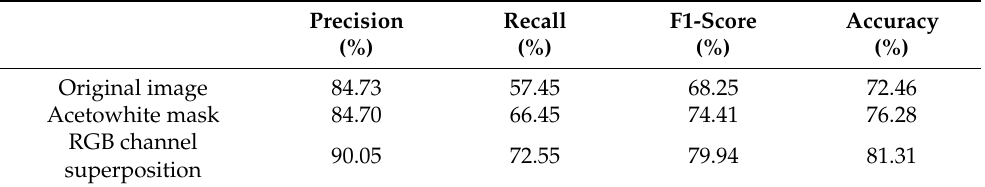
Table 2. Performance evaluation score of each deep learning model according to the applied